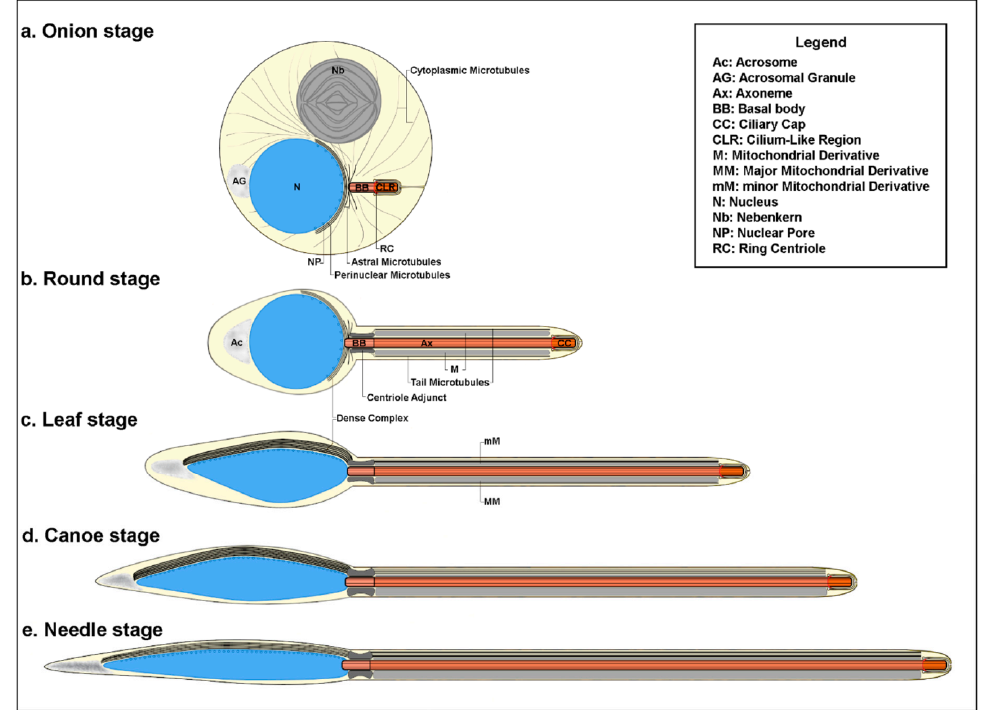
Figure 1. Schematic representation of the early stages of Drosophila